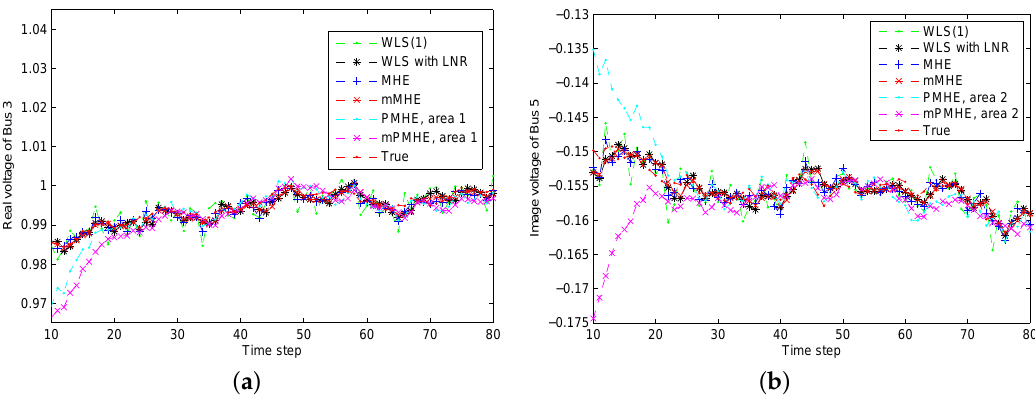
Figure 4. The estimated results of different estimators under Gaussian noise assumption. “WLS(1)” represents the results when the WLS estimator uses the measurements with horizon length 1. ( a ) the real part of Bus 3 voltage phasor. ( b ) the imaginary part of Bus 5 voltage phasor.